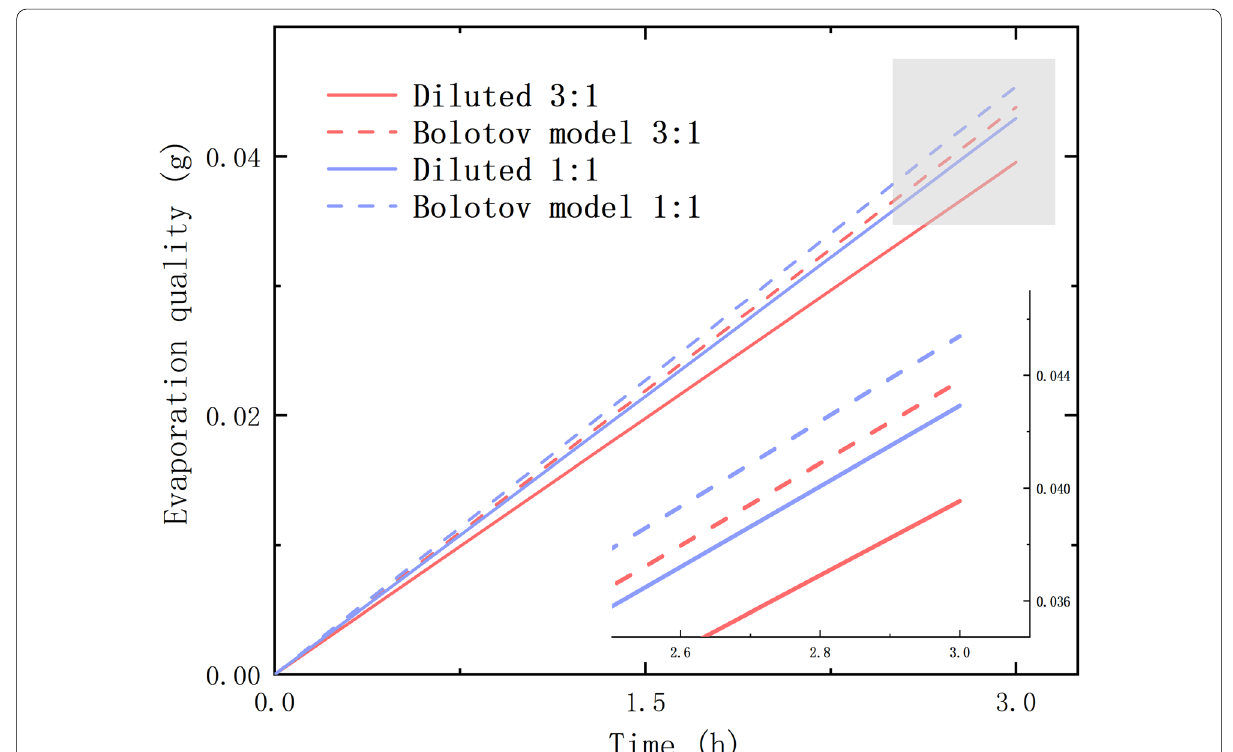
Figure 7 Prediction of the evaporation rate of the ferrofluid with different dilution